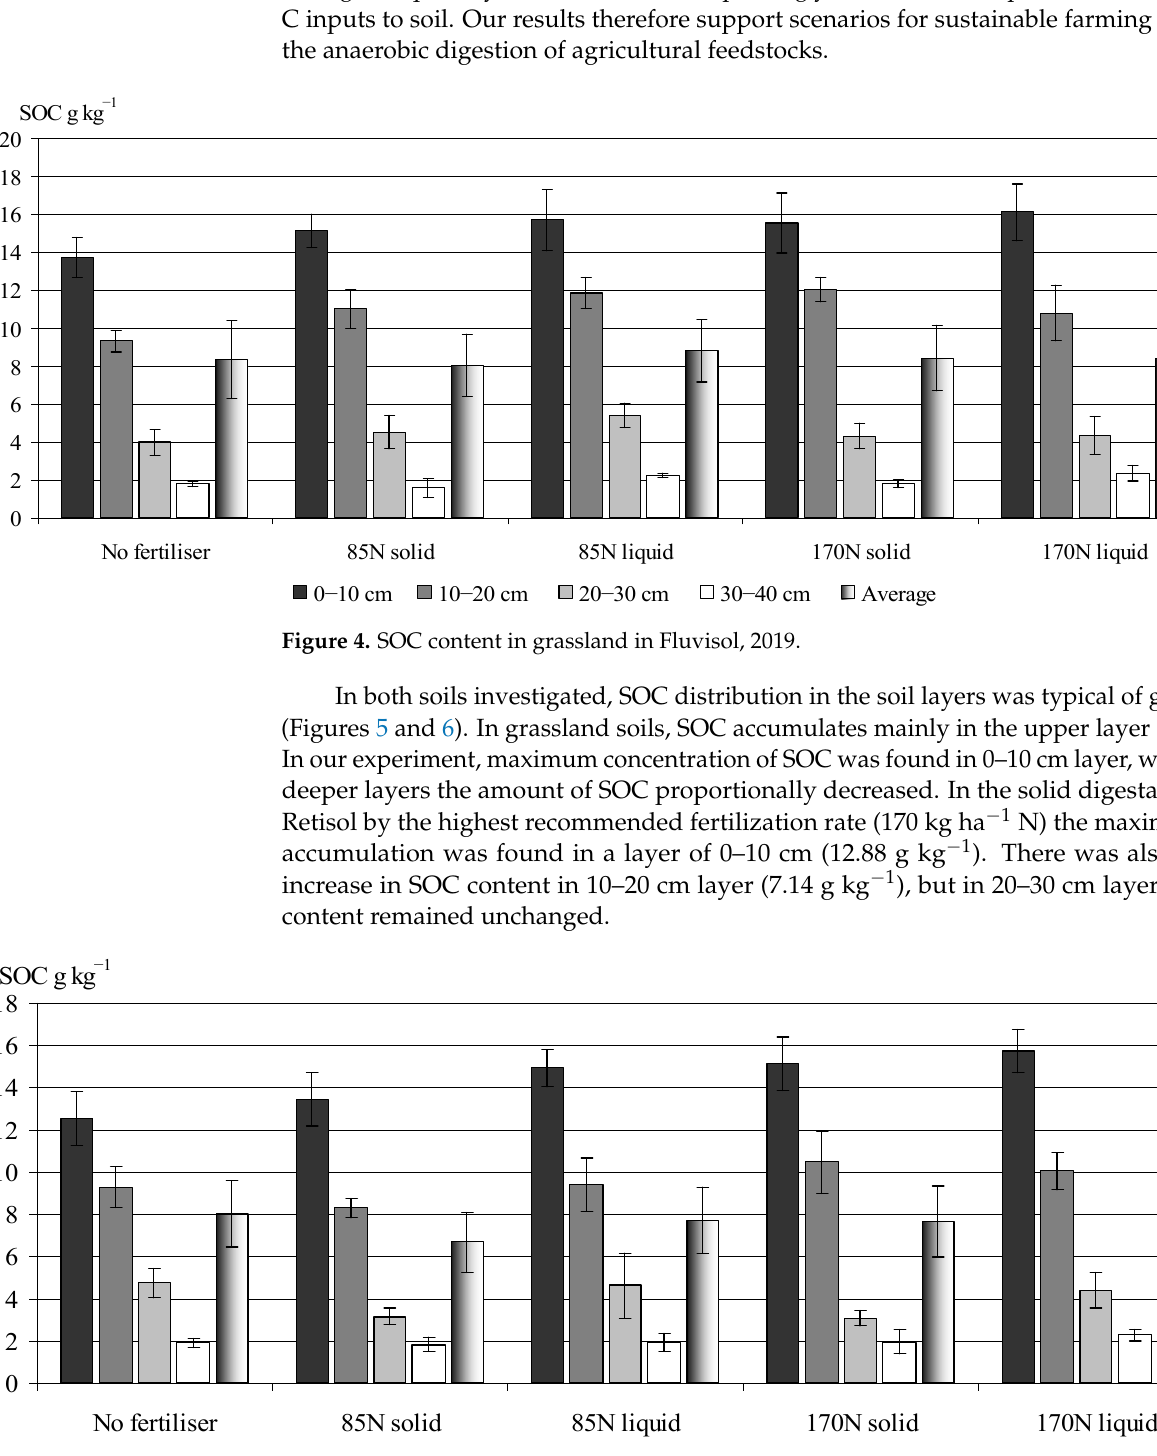
Figure 6. SOC content in grassland in Retisol, 2019 . SOC distribution in soil layers in Retisol (Figure 7) was also typical of grassland soils and was similar to that in Fluvisol. In this soil, the influence of fertilization on SOC in 0– 10 cm layer became more pronounced compared to Fluvisol. The change in the distribution of SOC in the soil layers is usually only observed dur- ing the longer time period due to the certain soil management practices. According to Hobley and Wilson SOC depth depletion appeared to be driven predominately by land-